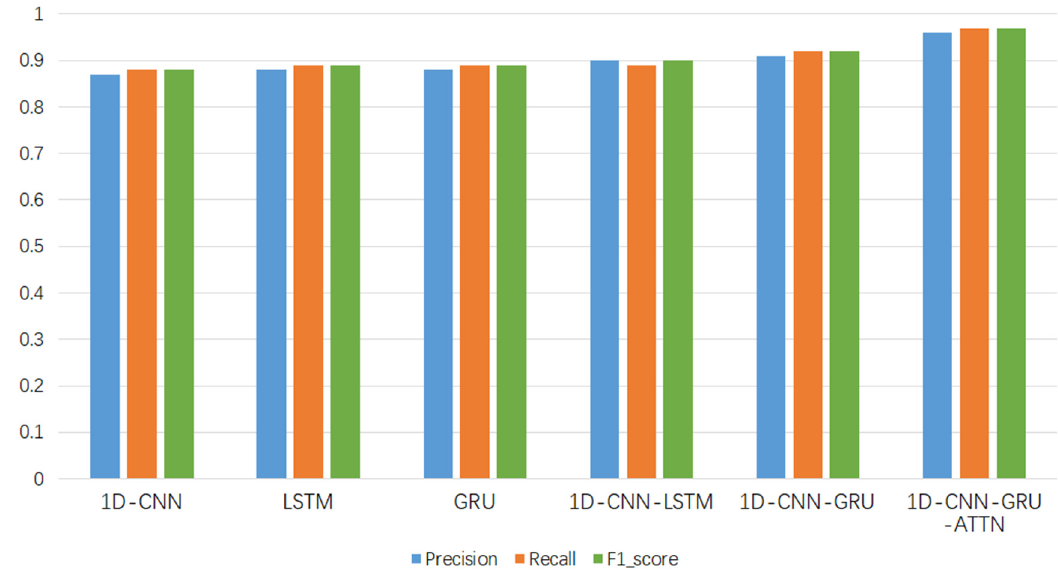
Figure 12. Evaluation indicators of each model.